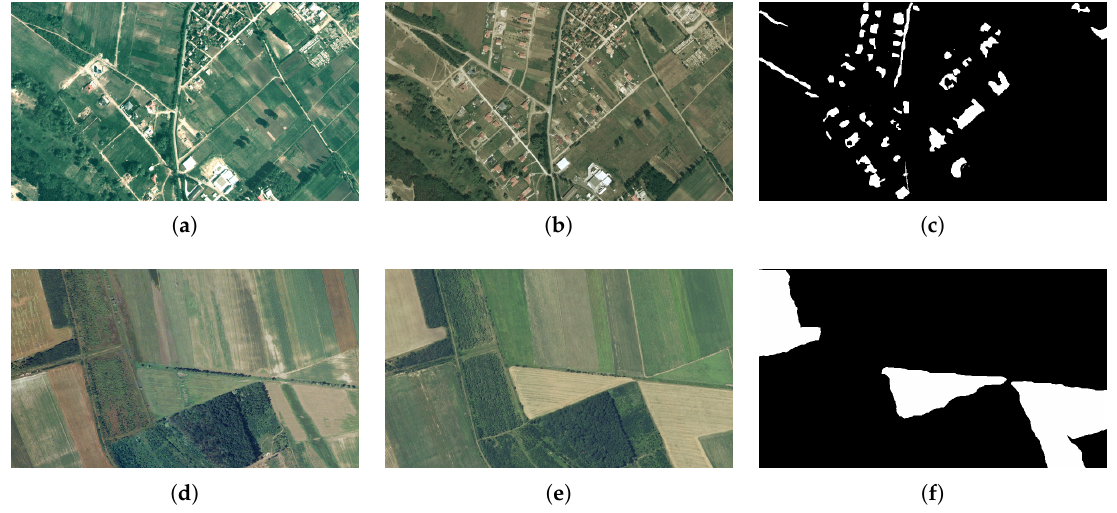
Figure 10. The test image pairs of SZTAKI dataset. ( a ) Image 1 of SZADA/1. ( b ) Image 2 of SZADA/1. ( c ) Ground truth of SZADA/1. ( d ) Image 1 of TISZADOB/3. ( e ) Image 2 of TISZADOB/3. ( f ) Ground truth of